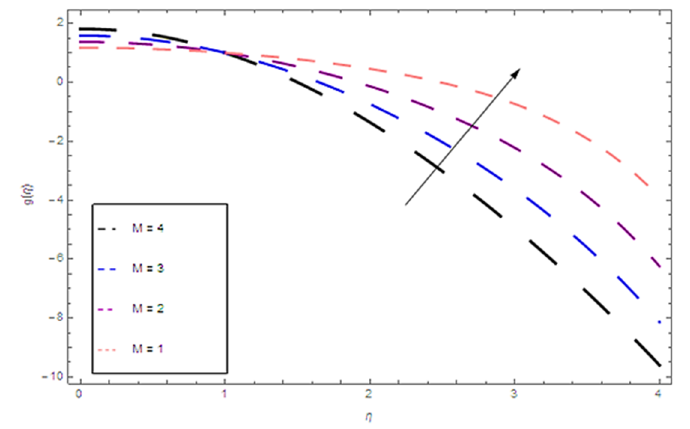
Figure 2. Impact of M on f ( η ) when k = 1.